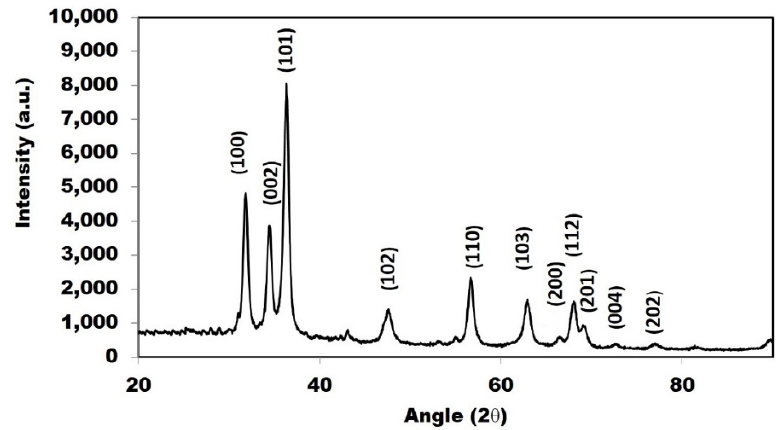
Figure 2. XRD pattern of the synthesized zinc oxide nanostructures.